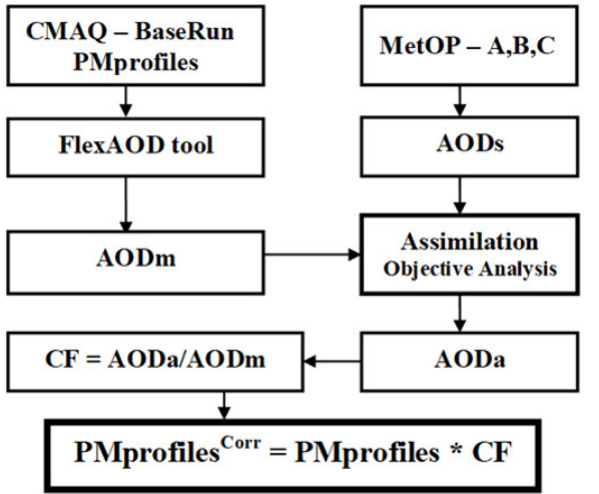
Figure 2. Algorithm for AOD assimilation in BgCWFS, “s”—satellite, “m” —model, “a” —assimilated, CF—correction factor, “PM”—species of particulate matter.